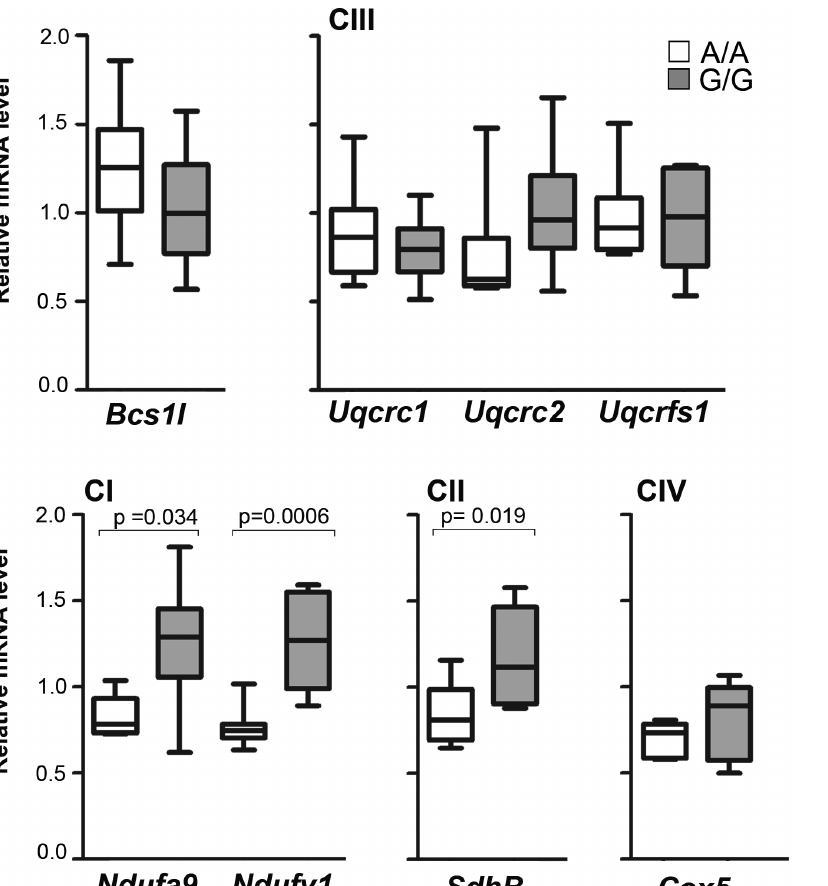
Figure 5. Increased expression of CI and CII subunits in liver tissue of sick Bcs1l G/G animals . The mRNA expression levels of Bcs1l and subunits of respiratory chain complexes were analyzed with quantitative PCR. In homozygotes, the subunits of CI and that of CII were significantly up- regulated in comparison with control animals.